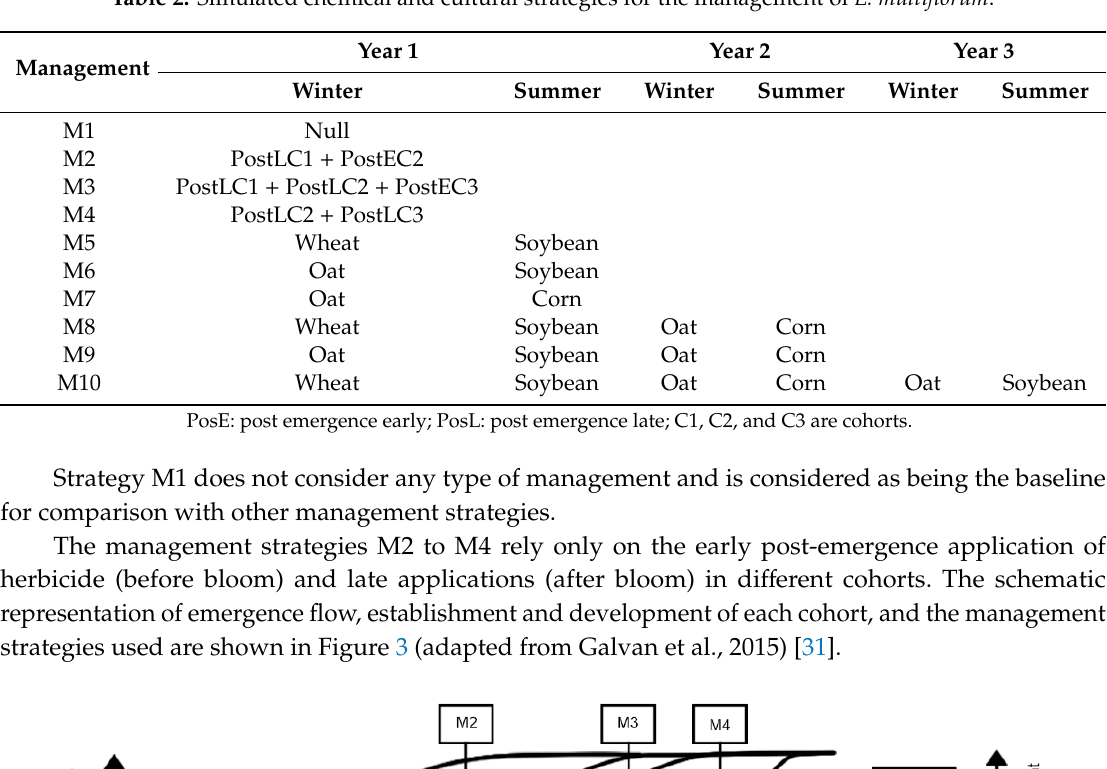
Table 2. Simulated chemical and cultural strategies for the management of L. multiflorum .